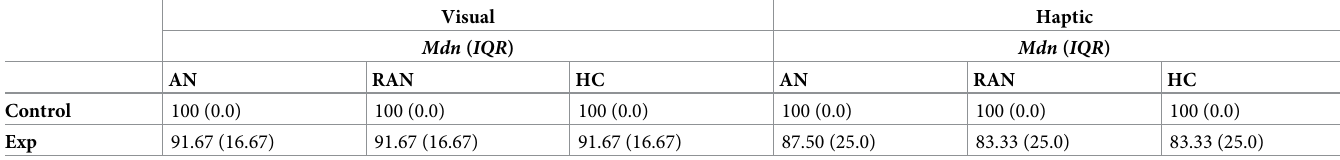
Table 2. Median and interquartile range of